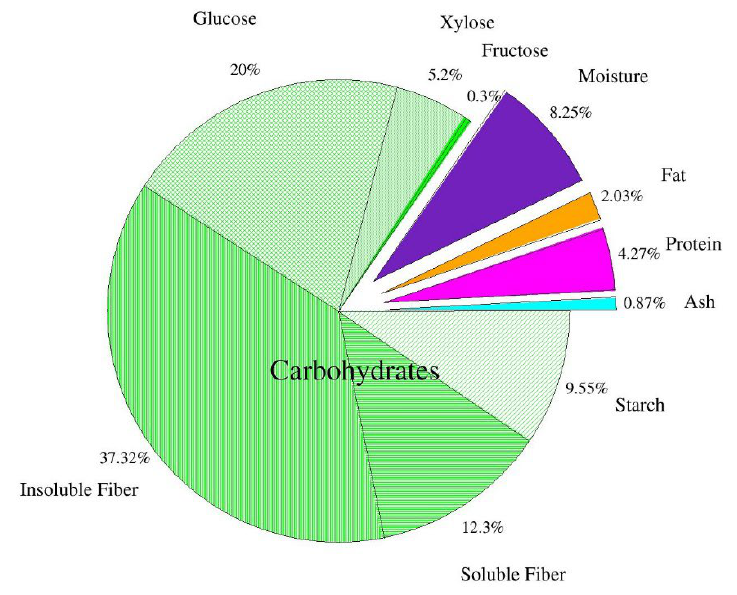
Figure 1. Chemical composition of dried apple pomace ( n = 2).